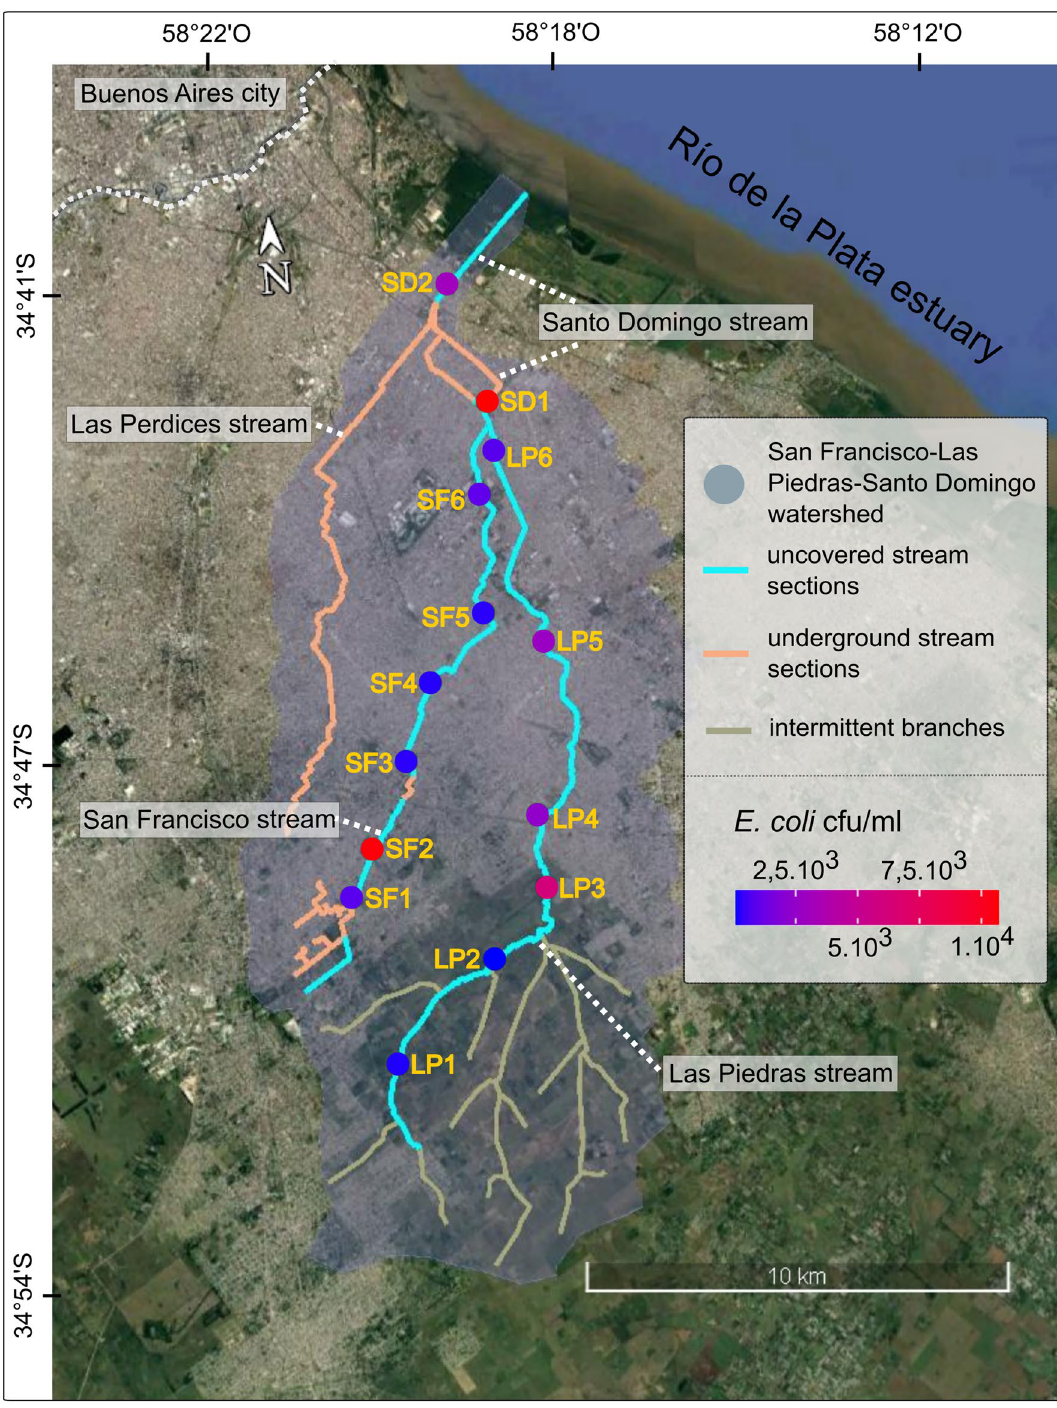
Figure 1. Location of the San Francisco-Las Piedras-Santo Domingo watershed and E. coli abundance across sampled sites. The studied watershed is located on the southern side of the Metropolitan Area of Buenos Aires. Spatial distribution of mean E. coli abundance (cfu/ml) at the sampled sites (dots) is color-coded in a blue-red gradient. LP, Las Piedras stream; SF, San Francisco stream; SD, Santo Domingo stream. Base map created in Google Earth V 7.3.3.7786. (October 5, 2020). Buenos Aires Metropolitan Area, Argentina. 34°46 ʹ 47.32 ʺ S, 58°19 ʹ 27.95 ʺ O, Eye alt 47.5 km. Maxar Technologies 2020. http:// www. earth. google. com. Graphical edition in Inkscape V 0.92.4. Inkscape Project (2020). https:// inksc ape.